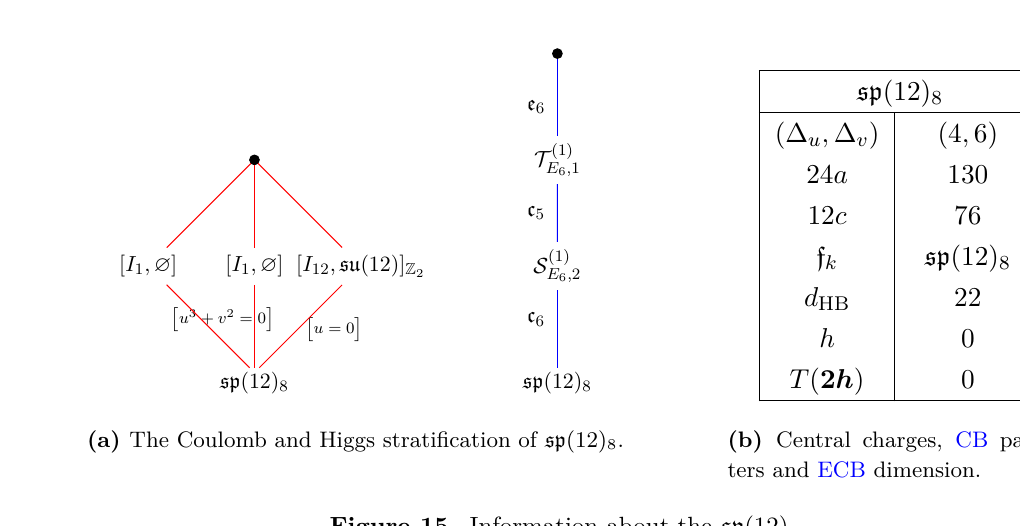
Figure 14. Information about the ( A 1 , A 4 ) AD theory.